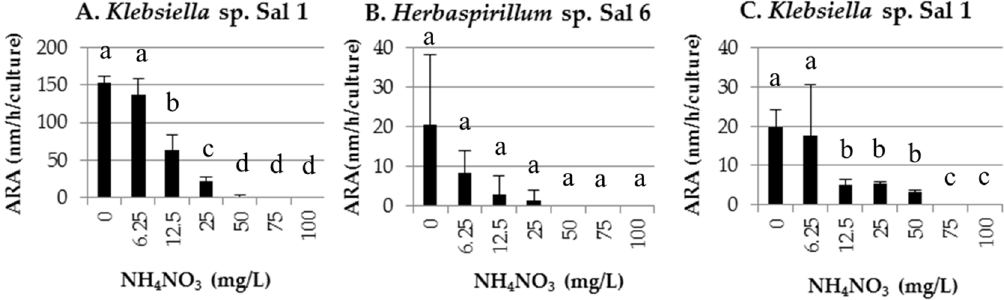
Figure 3. ARA in MR ( A , B ) and 1/2MS ( C ) agar medium at different levels of nitrogen. The bars represent standard deviation ( n = 3) and different letters indicate significant differences at P < 0.01 by Tukey’s test.